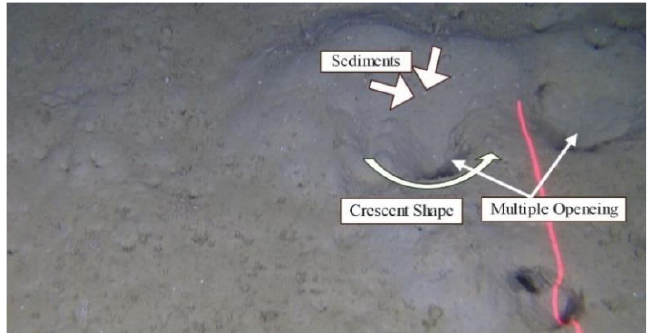
Figure 2. Nephrops burrow system.